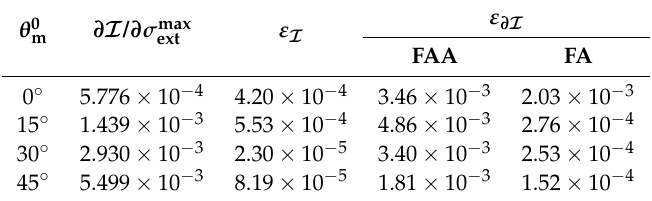
Table 3. Partial derivative ∂ I / ∂σ max ext , and the relative errors ε I and ε ∂ I for different values of the detector zenith angle θ 0 m . The results correspond to the solar azimuthal angle ϕ 0 = 0 ◦ and are computed with the linearized forward-adjoint approach (FAA) and the linearized forward approach (FA).